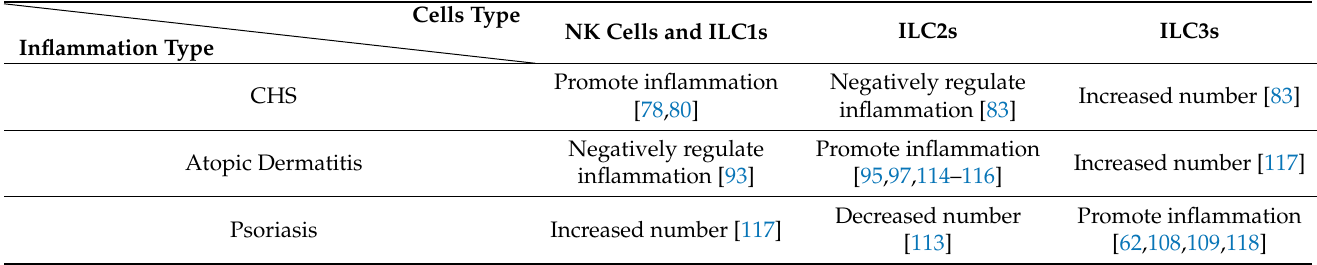
Table 1. The roles and changes of ILCs in inflamed